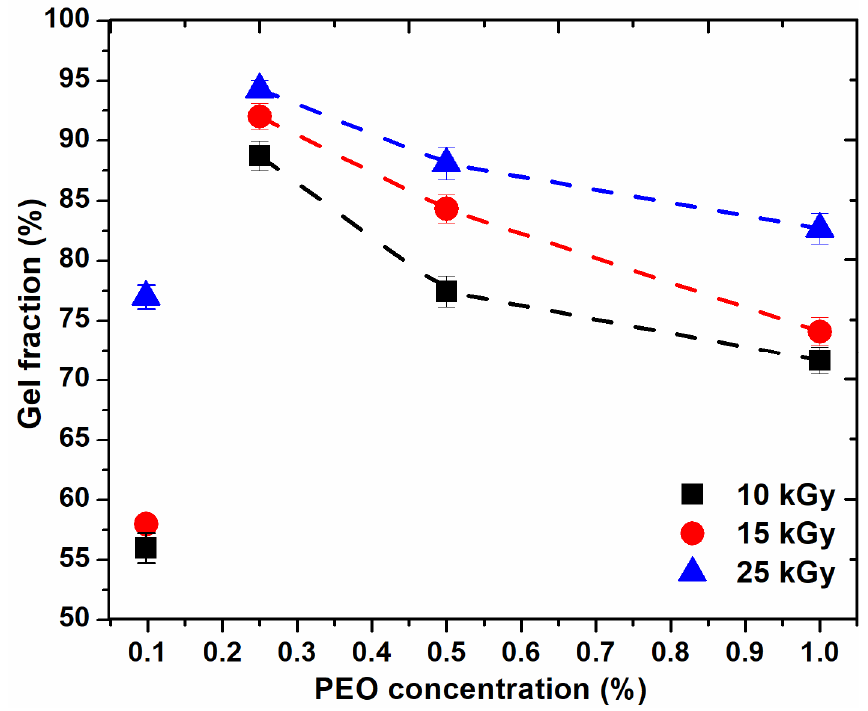
Figure 1. Variation of the gel fraction depending on the PEO concentration.